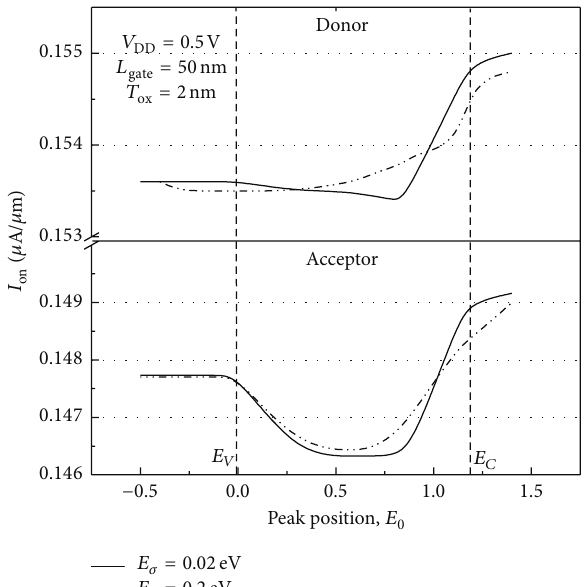
Figure 6: The extracted on-state current 𝐼 ITs and acceptor-type ITs; 𝑉